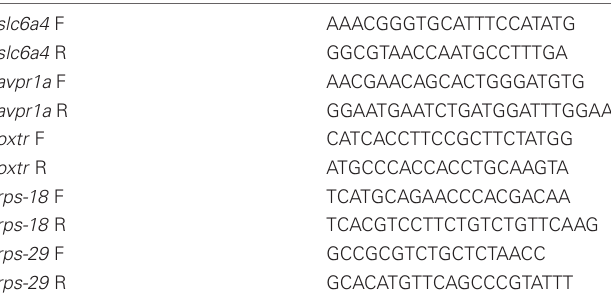
Table 1 | Primer sequences for the gene expression analyses of the selected